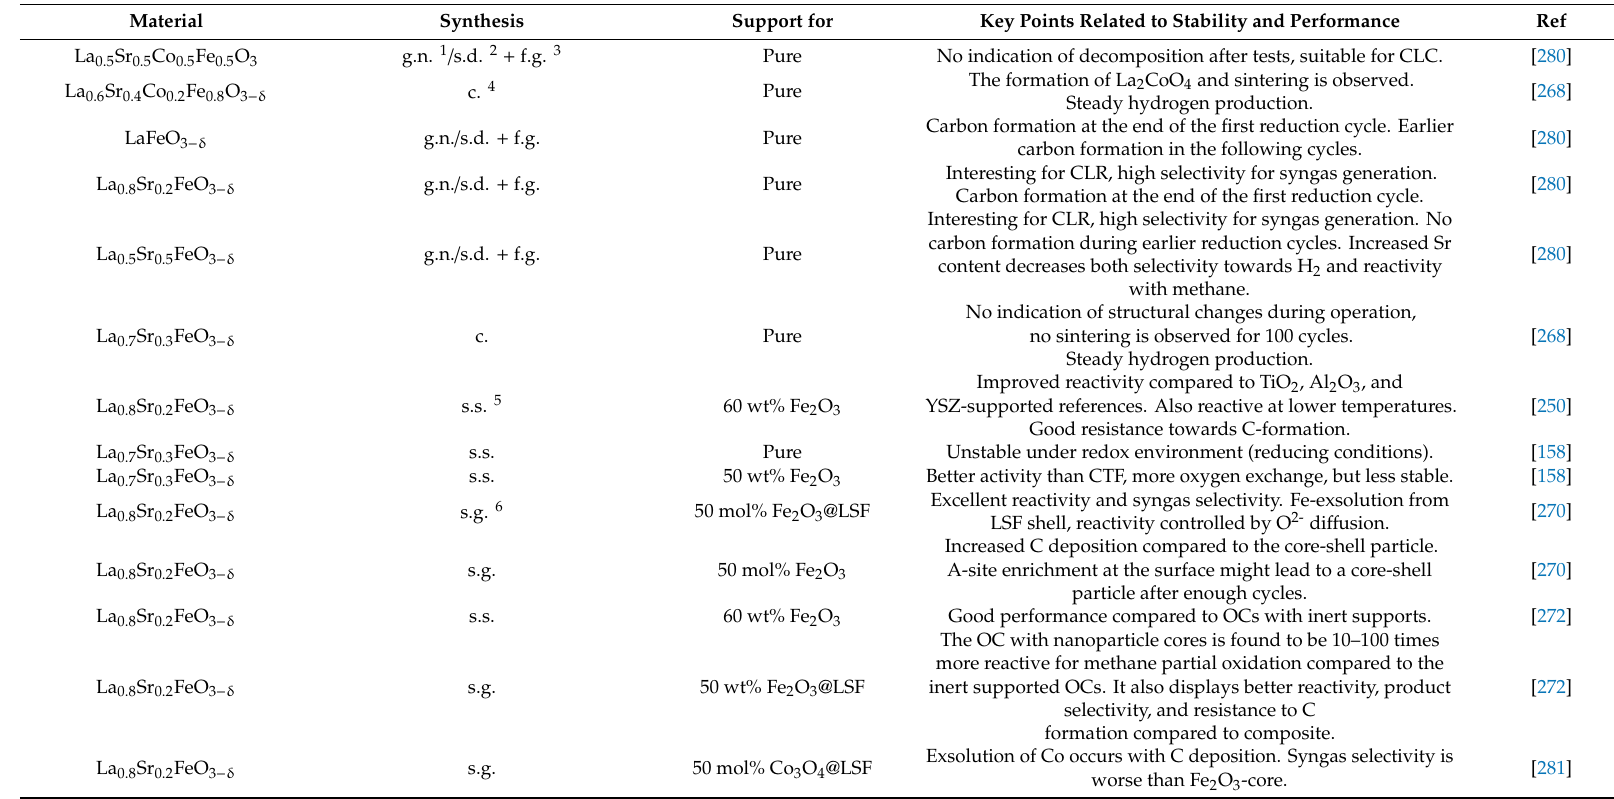
Table 4. Selection of perovskite and fluorite materials used in chemical looping, their synthesis procedure, and key points related to their stability and performance. Core-shell particles are indicated by